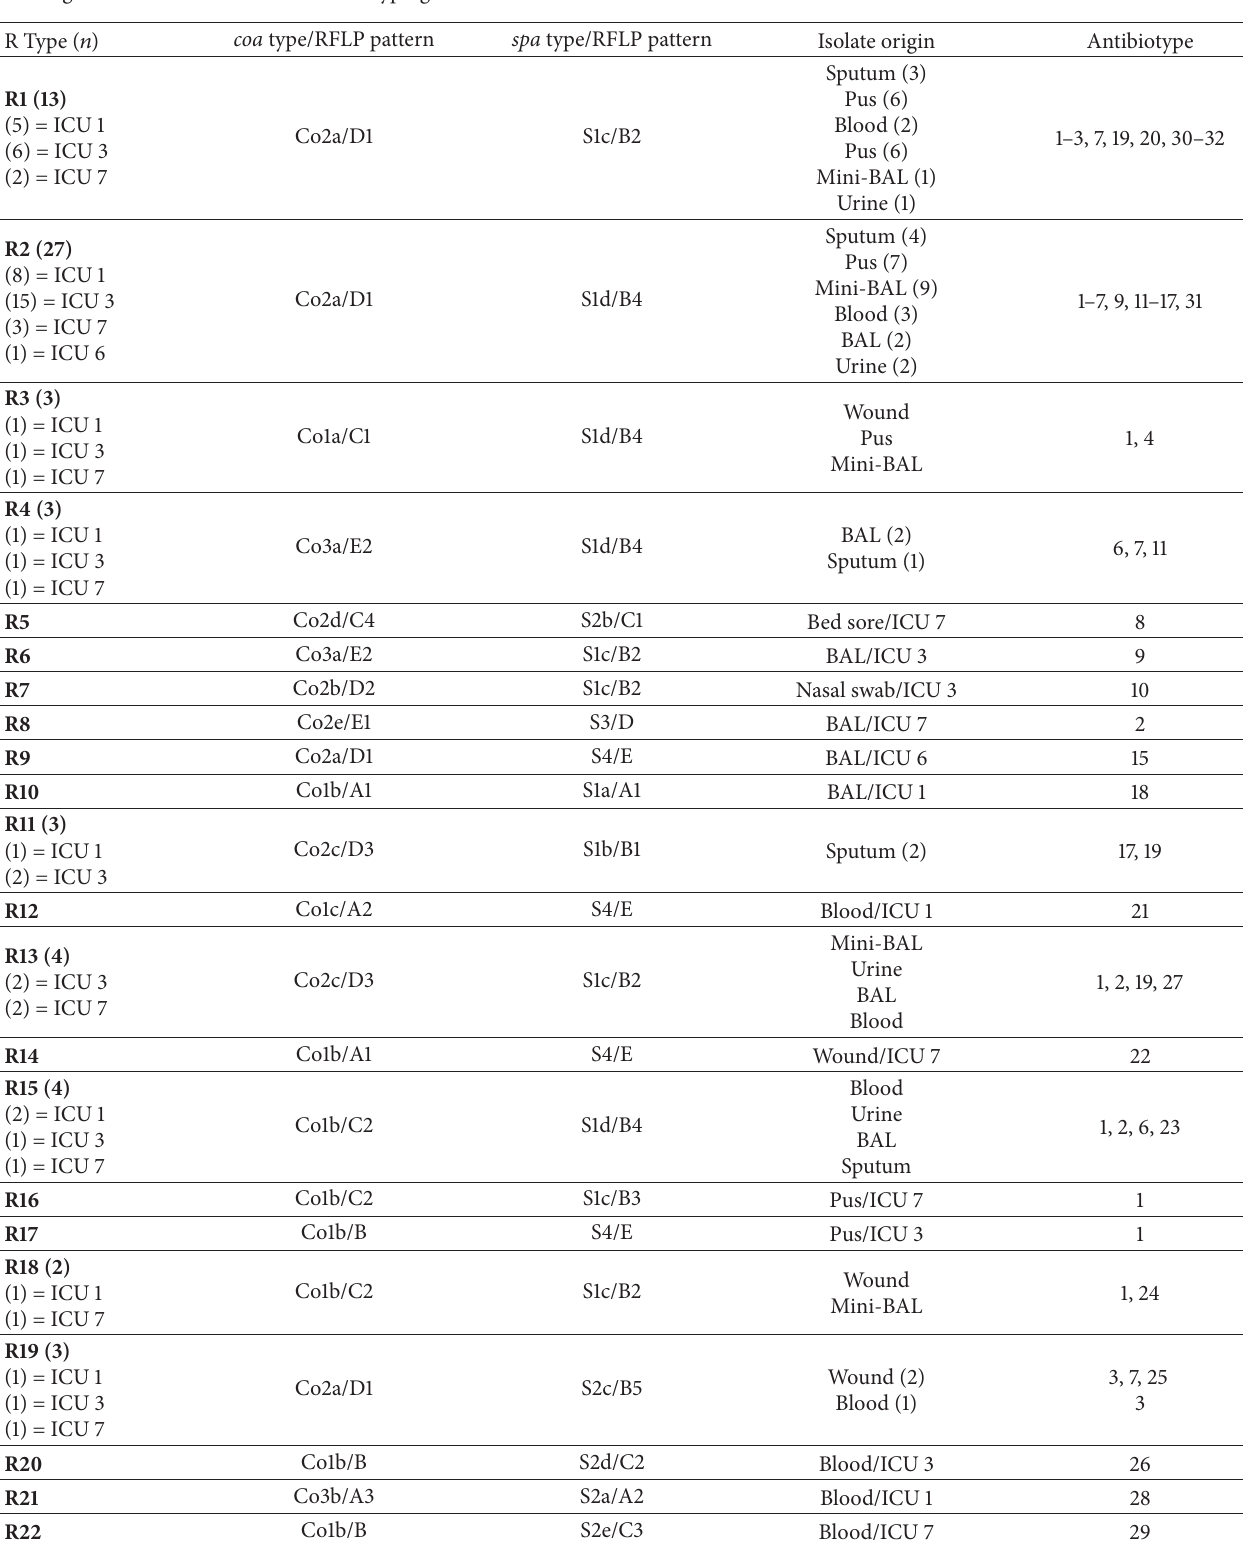
Table 3: Analysis of the discriminatory power of the binary typing method (R) compared with the coa and spa genotyping techniques and antibiogram estimated on the basis of the typing results for the 75 MRSA